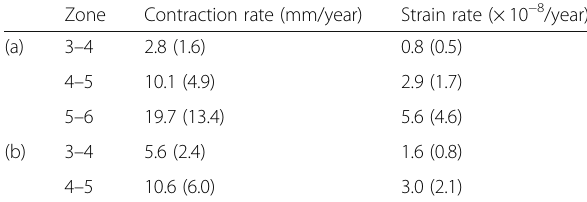
Table 2 Contraction rate and strain rate of the PHS slab beneath central Japan. The zone numbers represent the area bounded by the colored lines (e.g., the zone 4 – 5 is the area bounded by the green and red lines). The numbers in parentheses represent the cases with a tear beneath the